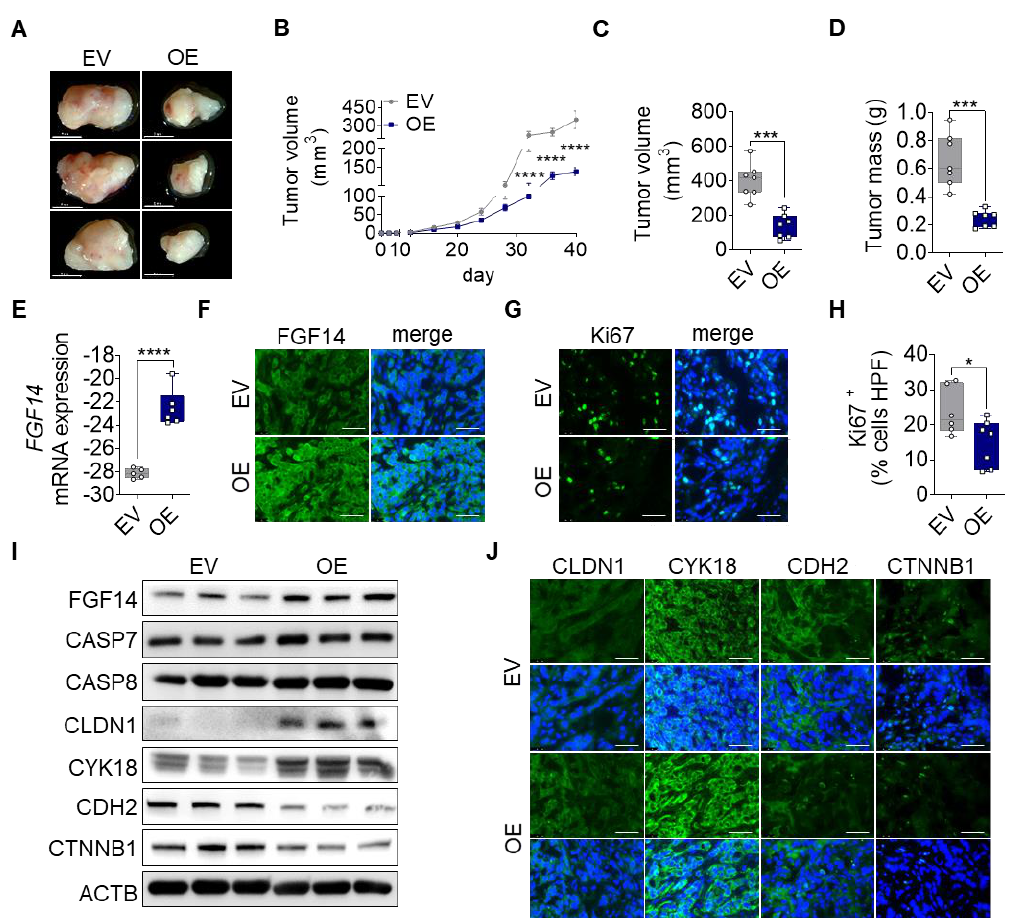
Figure 4. Impact of FGF14 overexpression on cancer progression in vivo . A549-EV and A549-FGF14 OE cells were injected in the right flank of immunodeficient mice. Tumors were harvested after 40 days. ( A ) Representative photographs of dissected FGF14 overexpressing tumors. ( B ) Measurement of tumor volume during tumor progression. Quantification of ( C ) tumor volume and ( D ) tumor mass after tumor dissection. Revalidation of FGF14 expression in mice tumor samples via ( E ) qPCR and ( F ) immunohistochemistry staining. ( G ) Ki67 staining of proliferating cells within the tumor were ( H ) counted per high power field using ImageJ (Fiji) Software. Representative pictures of FGF14 and Ki67 staining visualized using Alexa Flour 488 coupled secondary antibody (green). ( I ) Validation of FGF14 overexpression, apoptosis using antibodies against CASP7 and CASP8 and epithelial marker expressions using antibodies against CLDN1 and CYK18 and mesenchymal marker expressions evaluated by antibodies against CDH2 and CTNNB1. ( J ) Additional immunohistochemistry staining of epithelial and mesenchymal marker. Representative pictures of epithelial markers (CDH1 and CYK18) and mesenchymal markers (CDH2 and CTNNB1) visualized using Alexa Flour 488 coupled secondary antibody (green). Nuclear DNA was counterstained with DAPI (blue), scale bar 50µm. Data shown as mean ± standard error of the mean using one-way analysis of variance ( n =7). P- values ≤ 0.05 were considered statistically significant for all analyses. * p ≤ 0.05, *** p ≤ 0.001, and **** p ≤ 0.0001.